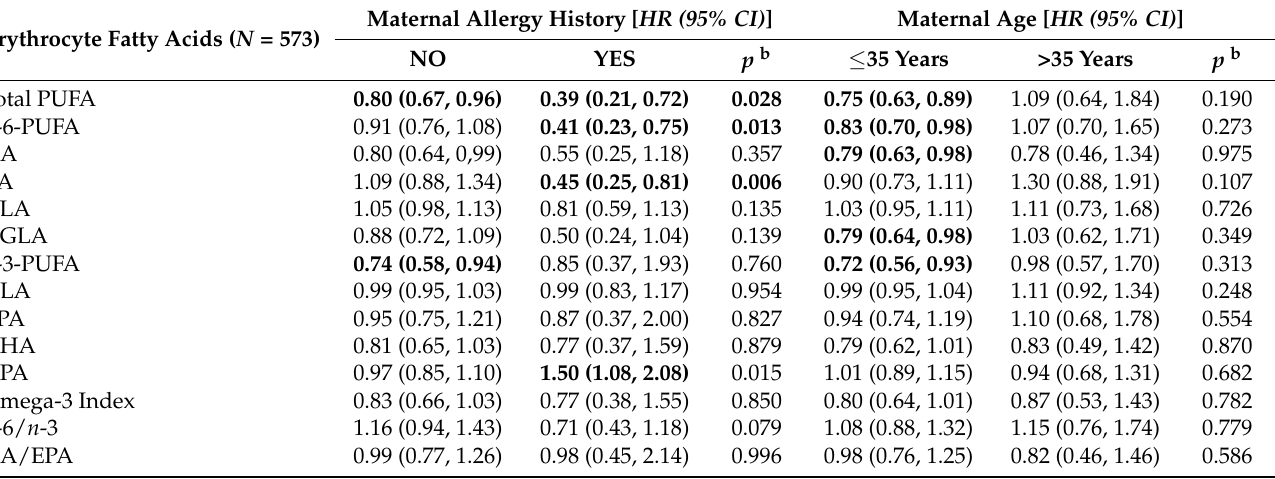
Table 4. The associations between maternal erythrocyte fatty acids and offspring allergic disease a within 2 years of age, stratified by maternal allergy history and maternal